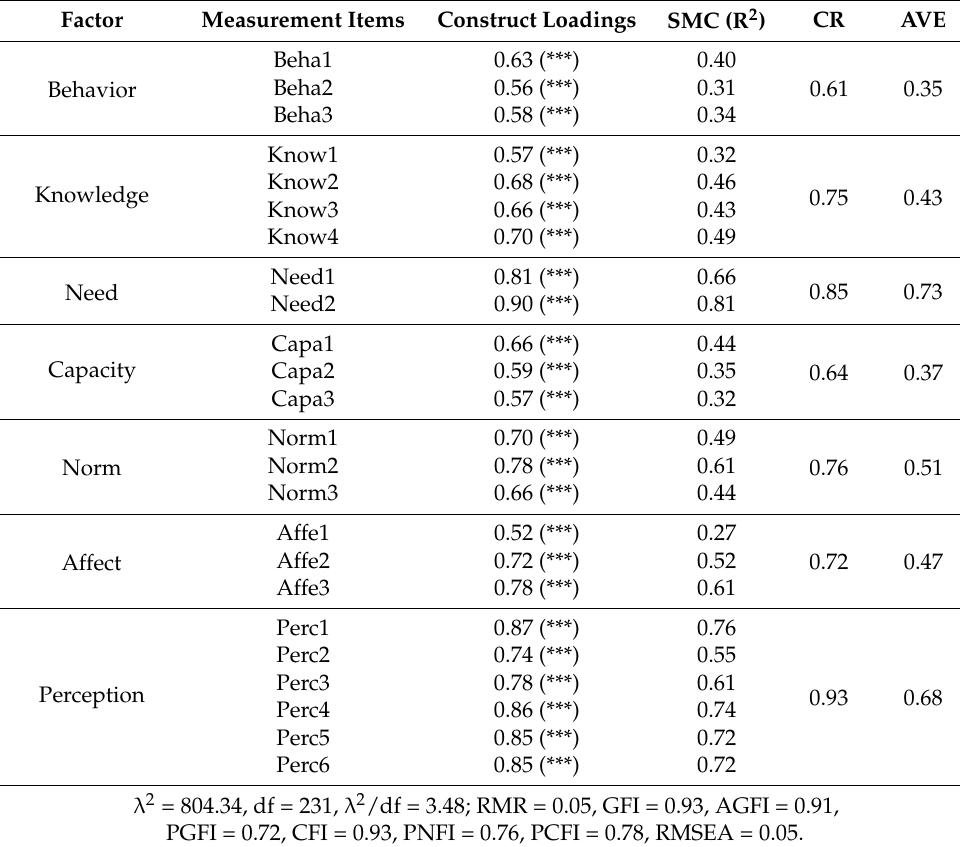
Table 2. Overall confirmatory factor analysis for the measurement